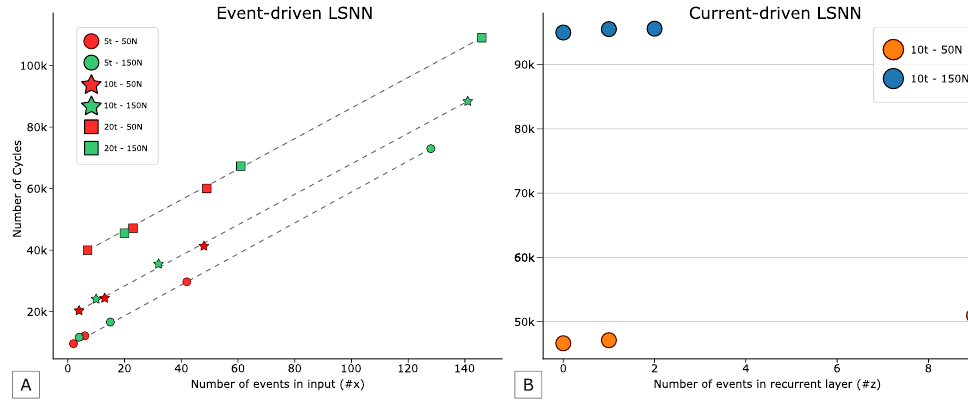
Figure 10. ( A ) Cycle count for the event-driven eLSNN for the best configurations (input number with different colours, and inference ticks with different markers) computed on minimal, median and maximal spike activities on the input-layer ( x ). ( B ) Cycle count for the current-driven eLSNN computed on minimal, median and maximal spike activities on the recurrent/hidden-layer ( z ). Different colour represent different number of inputs configuration for the eLSNN. All networks have an 10 inference ticks.